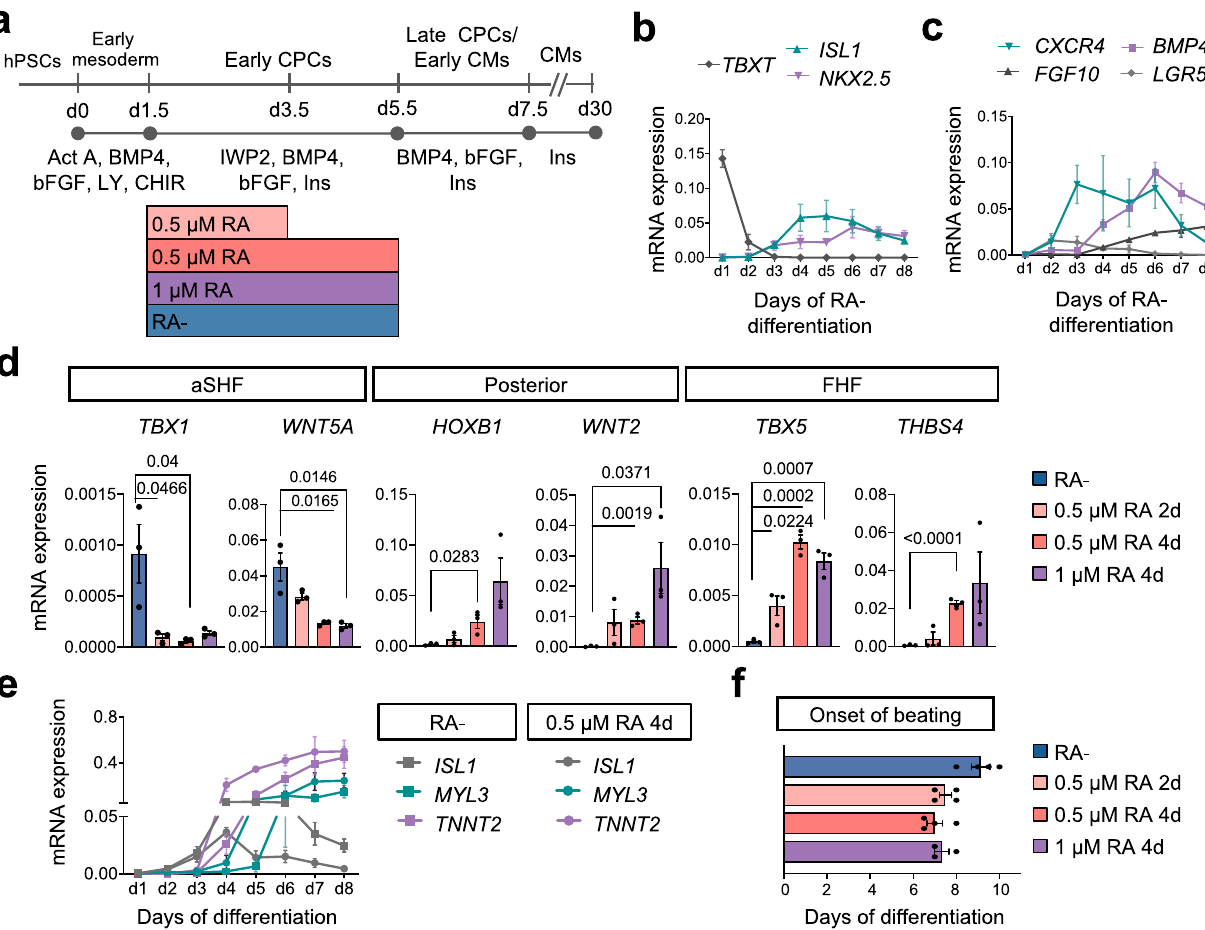
anteriorsecondheart fi eld(aSHF)markers,posteriorizationmarkers,and fi rstheart fi eld (FHF) markers at day 5 the indicated differentiation conditions. Data are mean±SEM; n =3 independent experiments. Exact p -values of unpaired two-tailed t -test are shown. e Time course of mRNA expression of ISL1, MYL3 , and TNNT2 during RA − and RA+(0.5 µ M 4d) differentiation. Data are mean±SEM. n =3 inde- pendent experiments. f Day of the onset of spontaneous beating at the indicated differentiation conditions. Data are mean±SEM; for RA+(1 µ M 4d) n =3 indepen- dent experiments; for all other conditions n